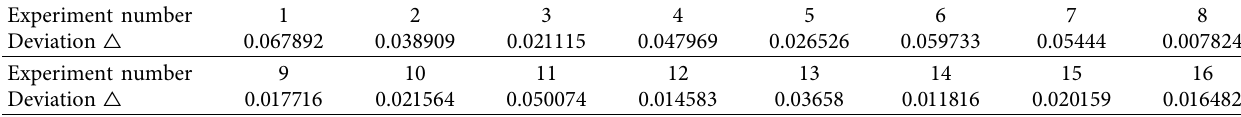
Table 6: Deviations of the orthogonal